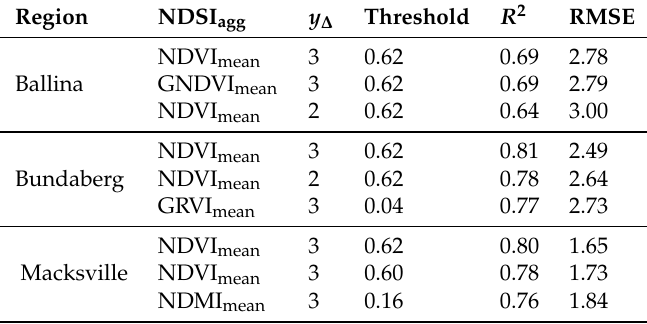
Table 3. Best 3 parameter sets when the optimal parameter search was performed per region.